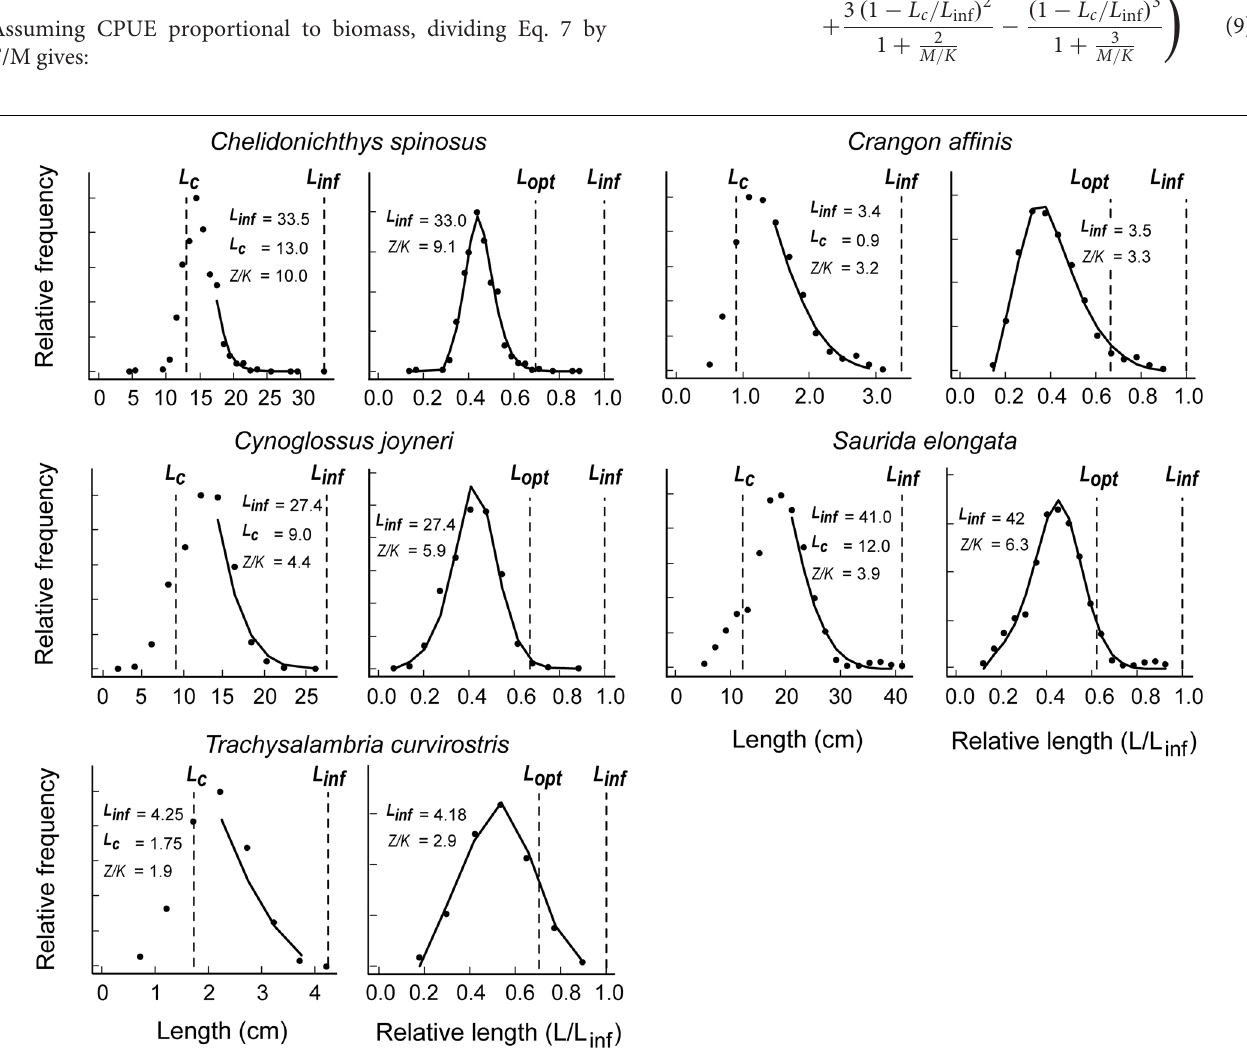
FIGURE 1 | Application of the LBB method to five species of commercially exploited fish for which length-frequency sample were obtained from cruises (see also Table 1 and Supplementary Tables S1, S2 ).